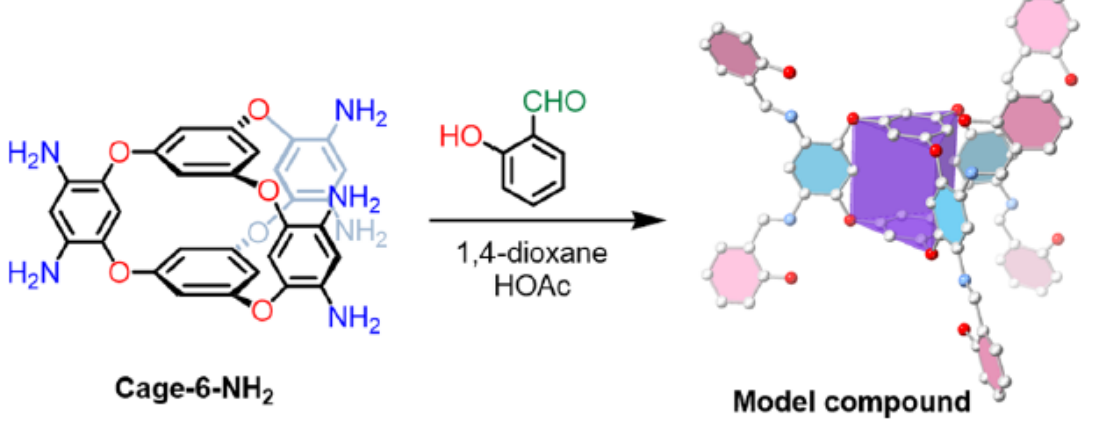
Figure 11. Synthesis of 3D Cage-COF [36].